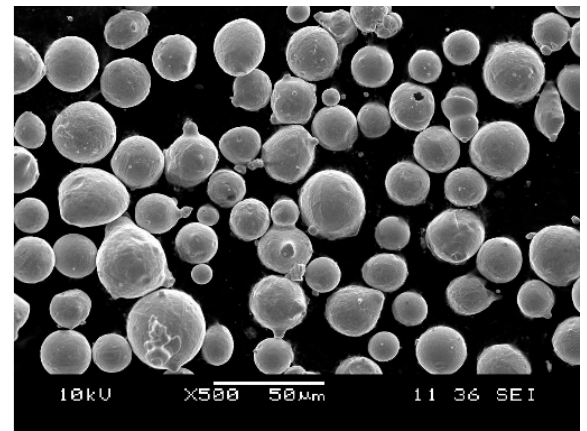
Figure 1. The morphology of the raw powder material.